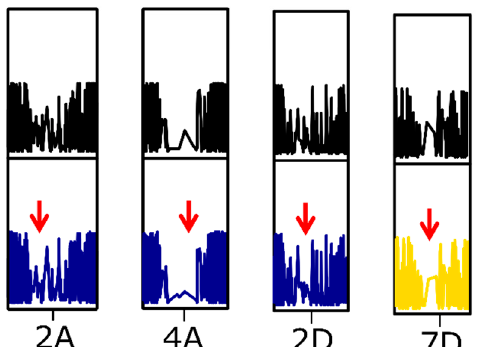
Figure 3. Genetic diversity (H s ) distribution across the genome in the primary set (PS) and the core collections generated with the maximization strategy (MCC), stratified sampling (SCC) and random sampling (RCC). Red arrows indicate lower genetic diversity regions when compared with the PS. Expanded subsections of these regions are shown.